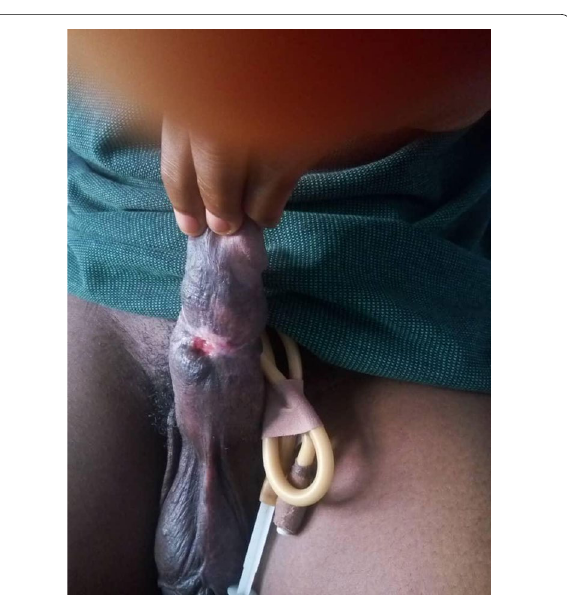
Fig. 3 Penile GSW at 10 months post injury showing good take of buccal mucosal graft in addition to penile